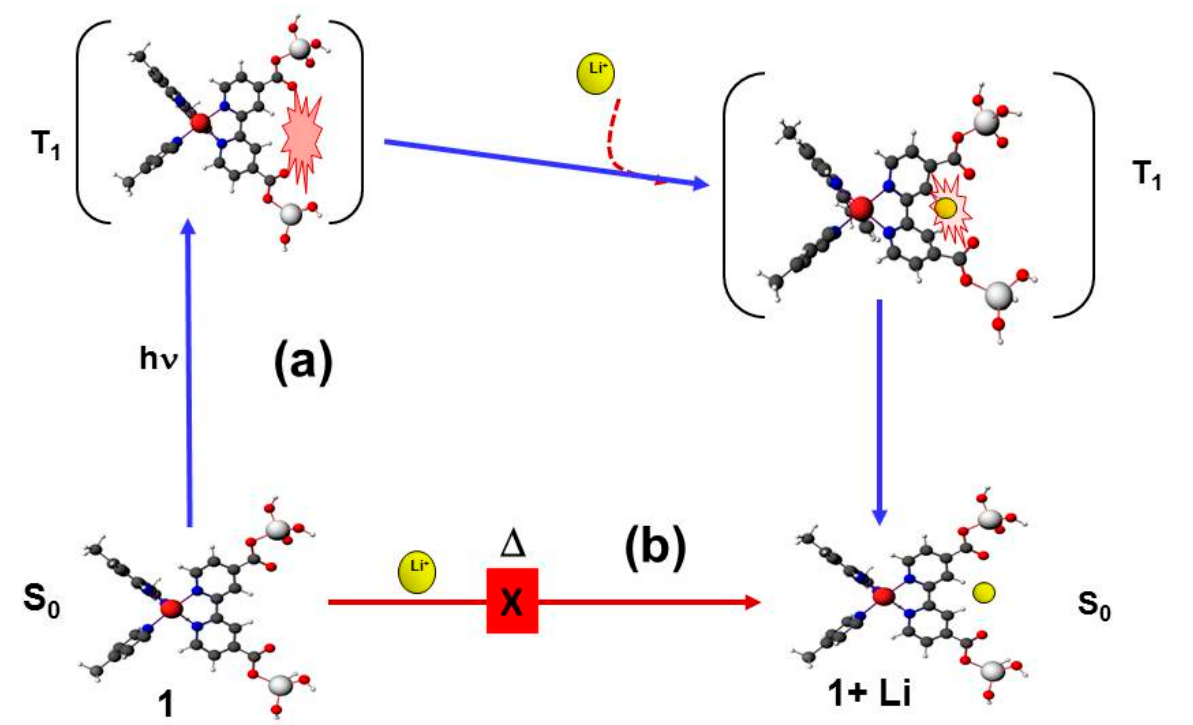
state S 0 → T 1 → S 0 , sensitization cycle ( b ) Thermal–dark pathway.